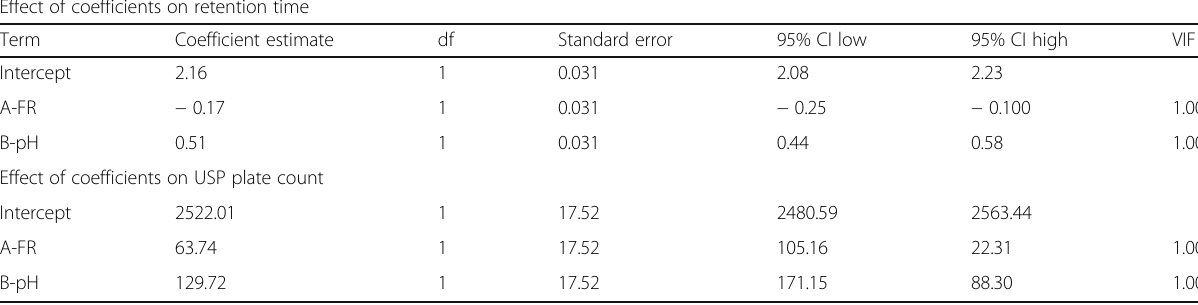
Table 2 Effect of analytical development coefficients Effect of coefficients on retention